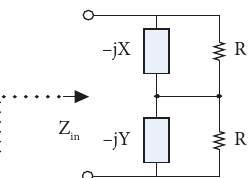
Figure 7: Te modifed RCN (two reactance components having diferent amplitude).